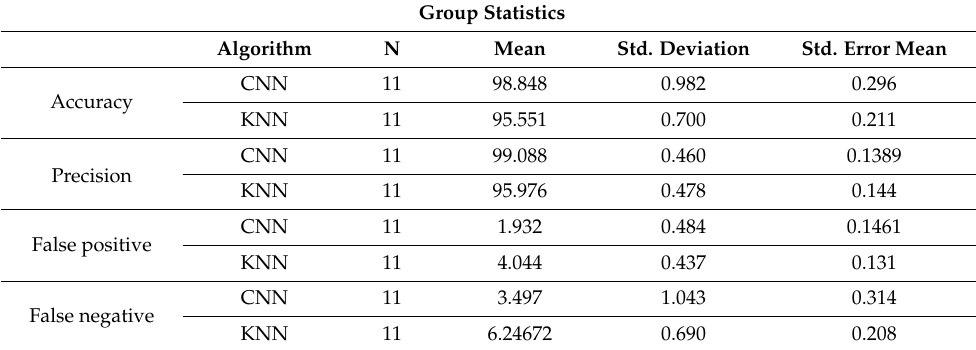
Table 5. Group statistics (mean, std. deviation, std. error mean) for performance measuring